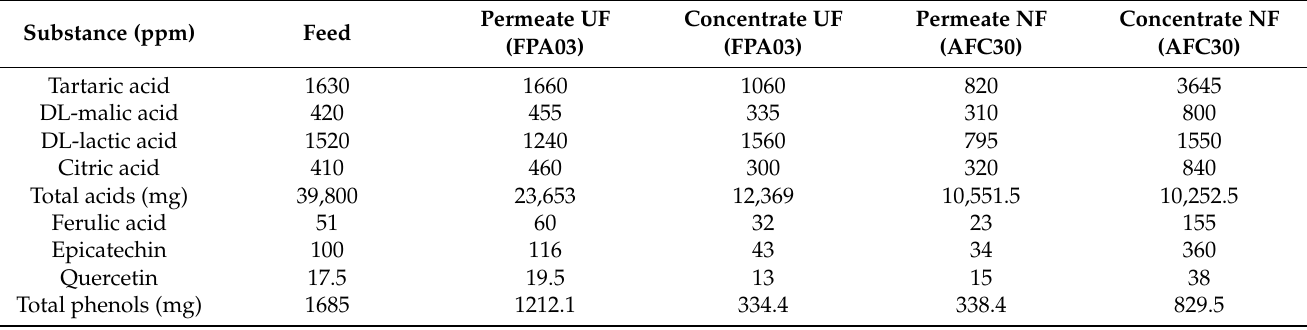
Figure 1. Permeability of ( a ) FPA03 (ultrafiltration) and ( b ) AFC30 (nanofiltration). Table 4. Concentrations of detected acids and phenols in process streams (average, n =